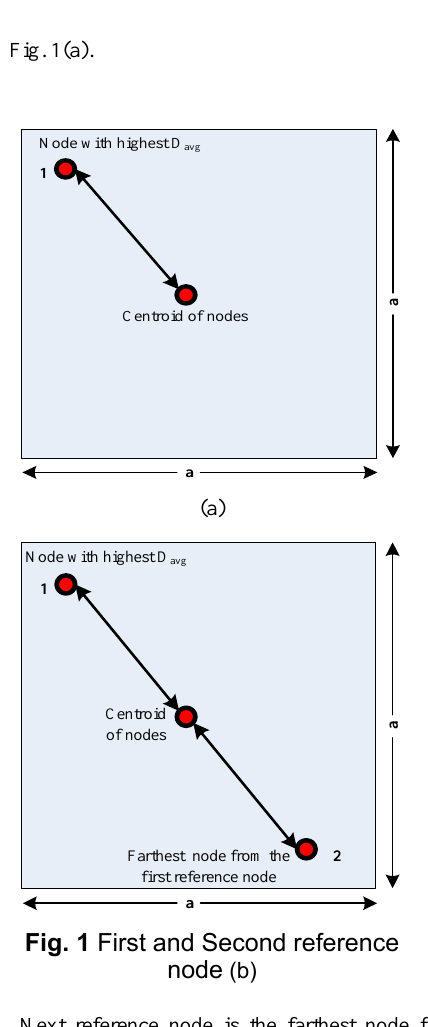
Fig. 1 First and Second reference node (b)